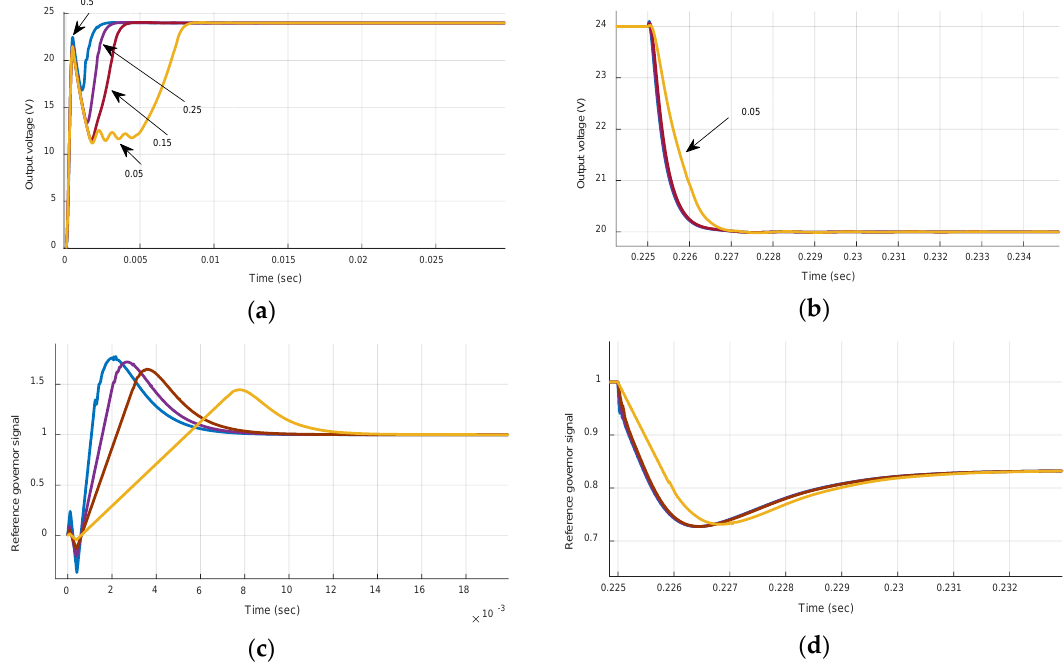
Figure 7. Effect of rate constraints ( ∆ r w = 0.05, 0.15, 0.25, 0.5) corresponding to cases Figure 1a,b. ( a ) Startup transient response for tracking a reference input of 24 V with an input voltage Vin = 12 V; ( b ) reference input changes from 24 V to 20 V; ( c ) reference governor signal of case ( a ); ( d ) reference governor signal of case ( b ).